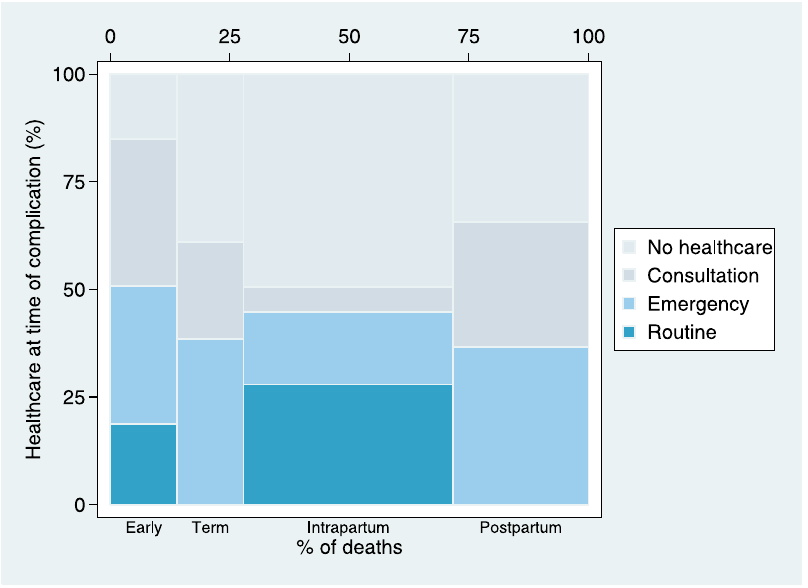
Figure 3. Proportion of highest healthcare sought by timing of direct maternal death. x-axis: Survey weighted proportion of timing of direct maternal death (n=919) with respect to the pregnancy: early termination (spontaneous or therapeutic), term antenatal complication ( $ 7 months), intrapartum, postpartum. y-axis: Highest healthcare sought at onset of complication leading to death: routine admission to health-facility/ hospital for abortion or labour, emergency admission for complication, community consultation for complication, no facility-based healthcare utilization at time of complication.